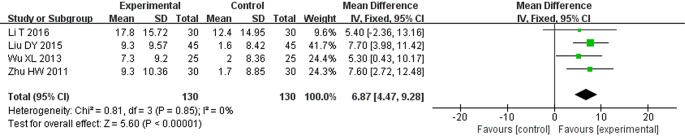
Meta-analysis for comparison of estimated glomerular filtration rate (eGFR) levels between the experimental and control groups.